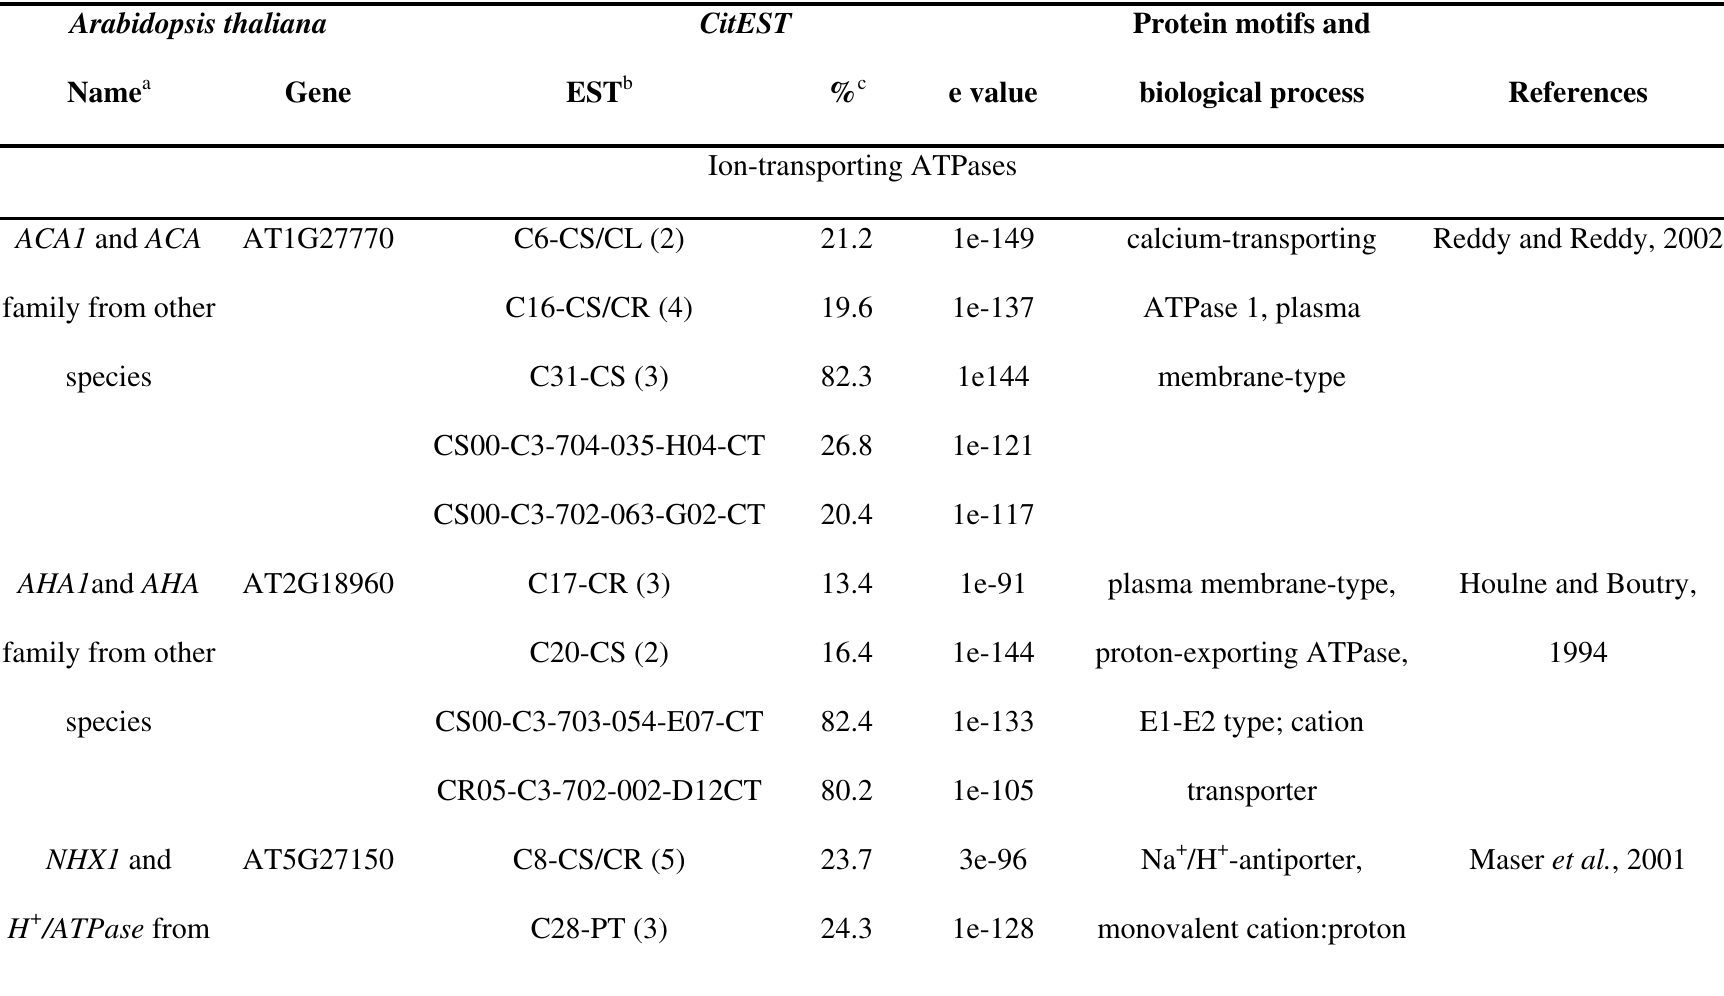
Table S1 – Citrus ESTs with homology to functionally characterized genes involved in ion transporters from Arabidopsis thaliana and other model